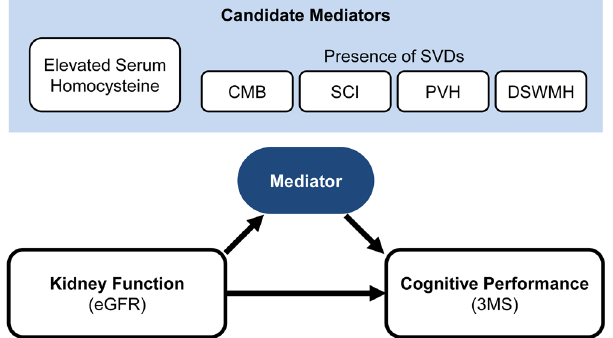
Figure 1. Study hypothesis. Decreased kidney function is associated with low cognitive performance. We hypothesized that elevated serum homocysteine and/or the presence of SVDs could mediate the link between kidney function and cognitive performance in patients with diabetes mellitus. The analysis was done by adjustment for potential confounders. Abbreviations are: eGFR, estimated glomerular filtration rate; CMB, cerebral microbleed; SCI, silent cerebral infarction; PVH, periventricular hyperintensity; DSWMH, deep and subcortical white matter hyperintensity; 3 MS, Modified Mini-Mental State